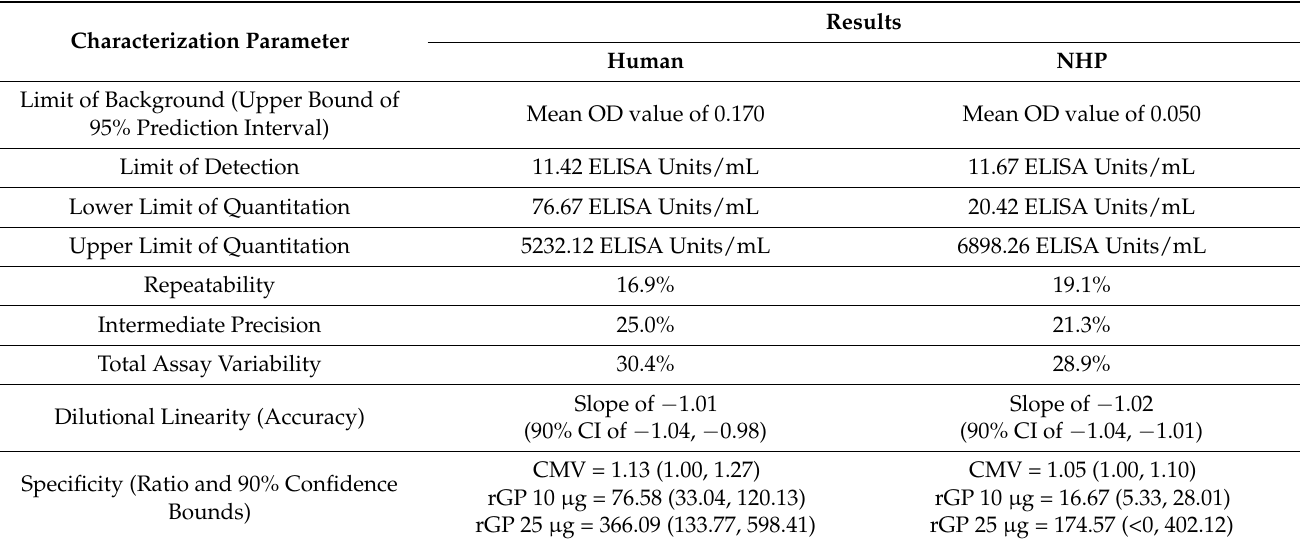
Table 2. Summary of Anti-MARV GP IgG ELISA Qualification Results.